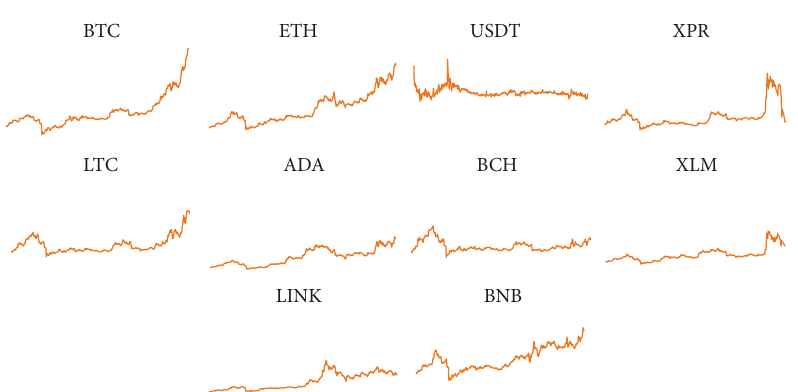
Figure 1: Price trade for the top 10 cryptocurrencies in the